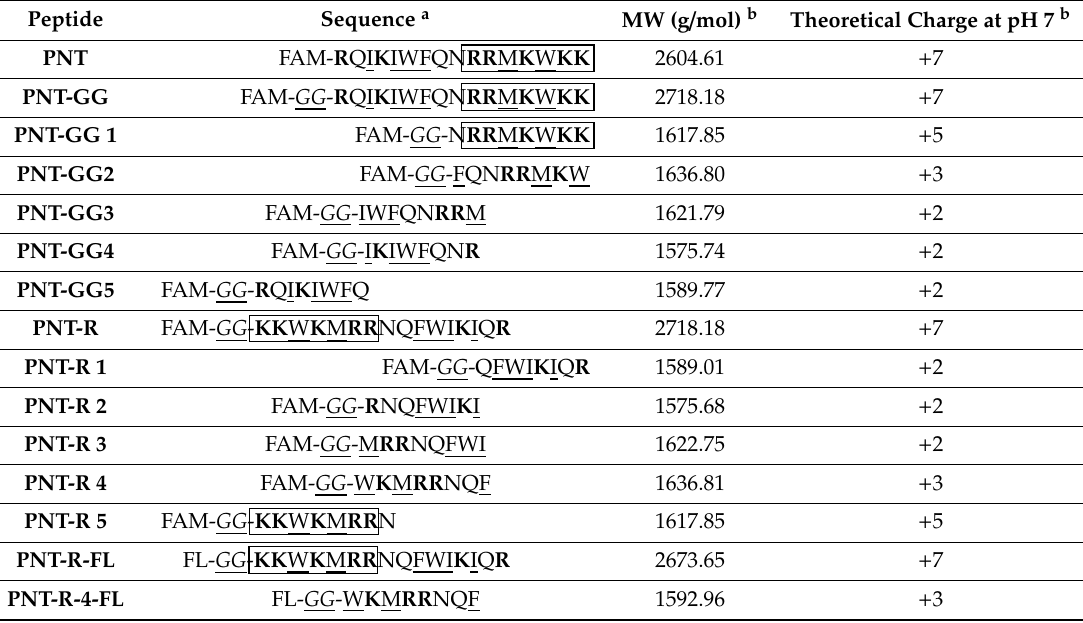
Table 1. Sequences of PNT and synthesized